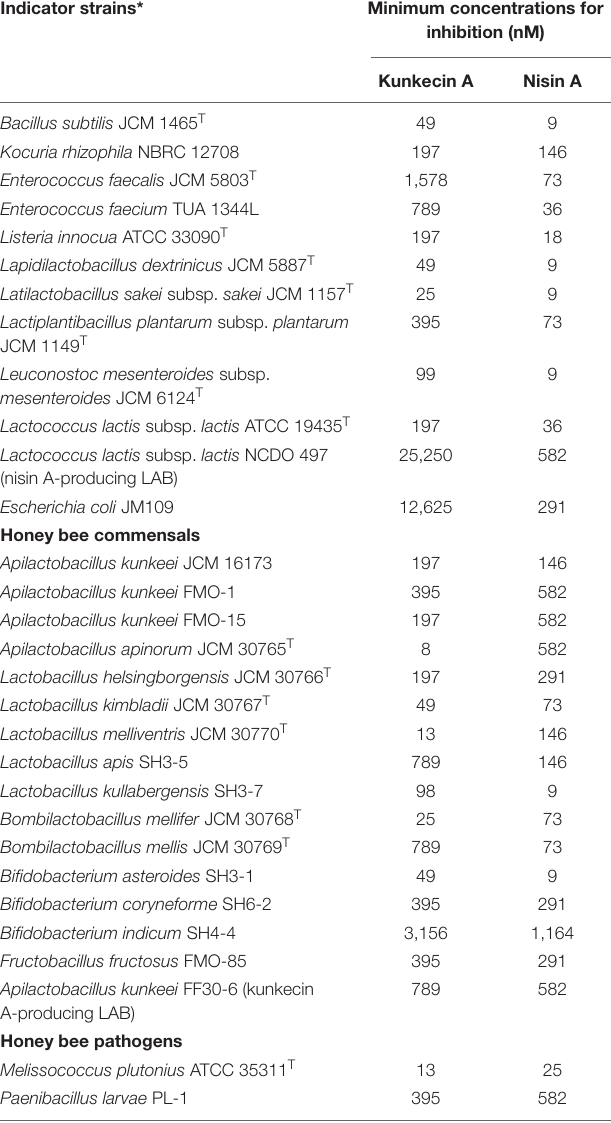
TABLE 2 | Antimicrobial spectra of kunkecin A and nisin